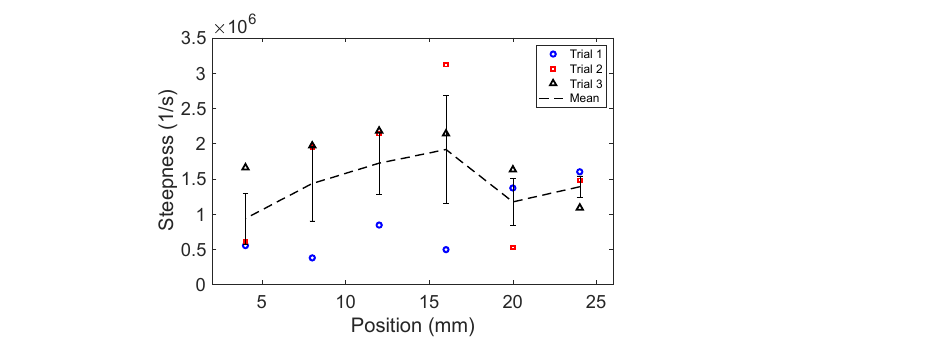
Figure 8. Steepness of Ti-6Al-4V AM waveforms in Figure 6 as a function of propagation distance, with mean and standard deviation.